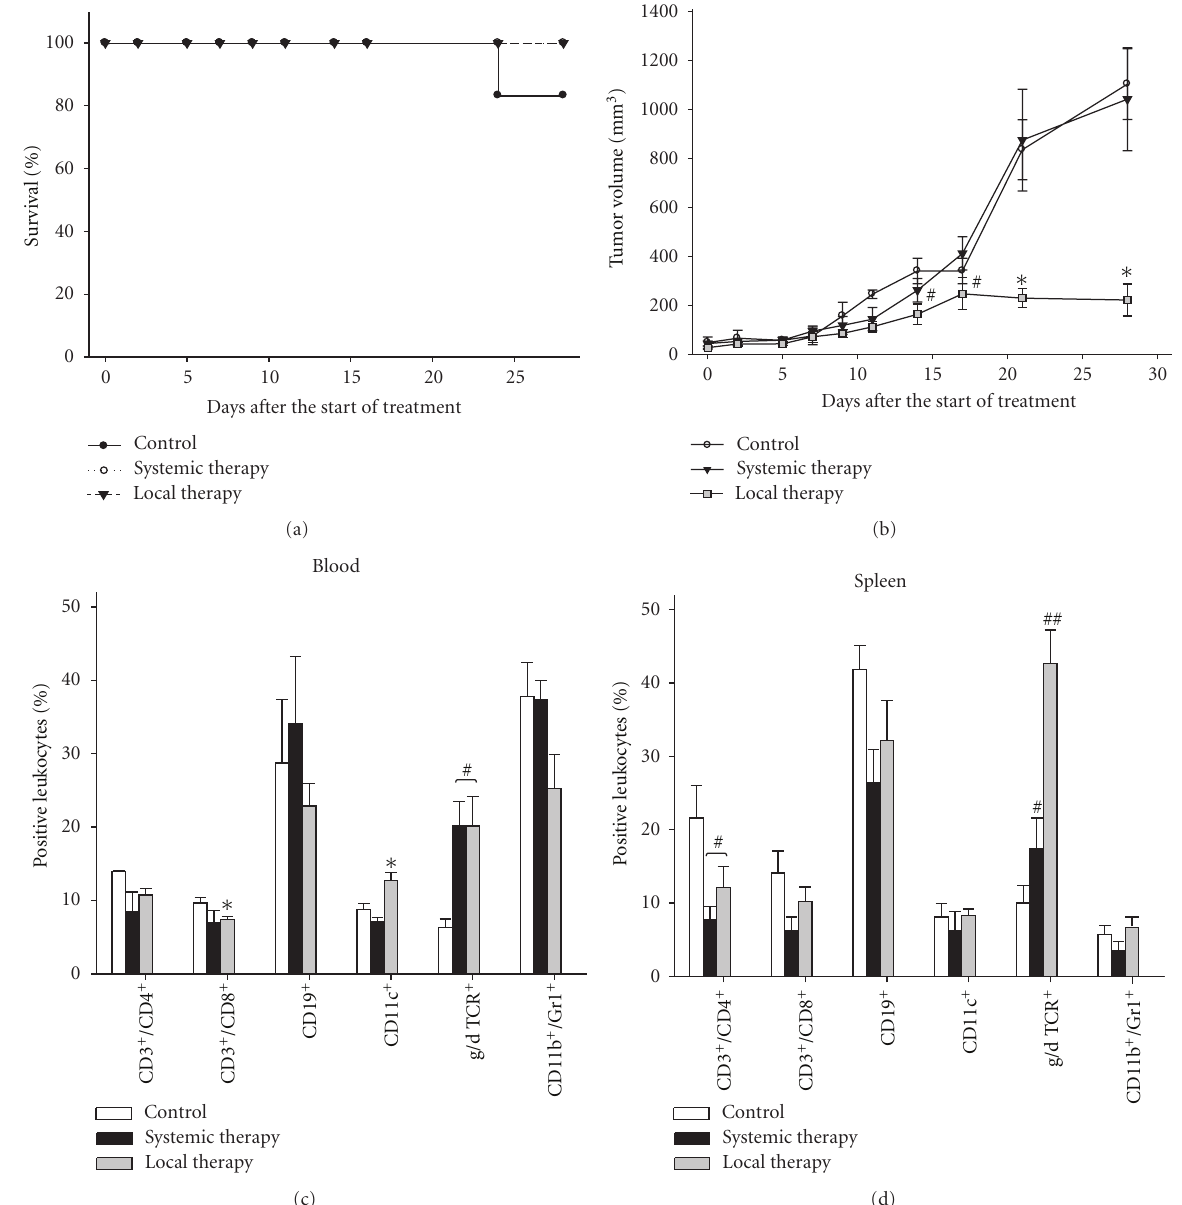
Figure 6: In vivo analysis. (a) Survival curve of Panc02 tumor-carrying C57Bl/6N mice and (b) tumor growth kinetic. After tumor establishment, mice received twice weekly i.t. or i.v. CT injections (six times in total ( n = 3–7 mice per group). Control mice were given PBS. Mice were monitored for 28 days with adherence to ethical requirements. (c), (d) Flow cytometric phenotyping of circulating (blood) and splenic leukocyte subsets from tumor control and CT-treated animals. Values are given as mean ± SEM; ∗ P < 0 . 05 versus control; t -test. # P < 0 . 05 versus control; U